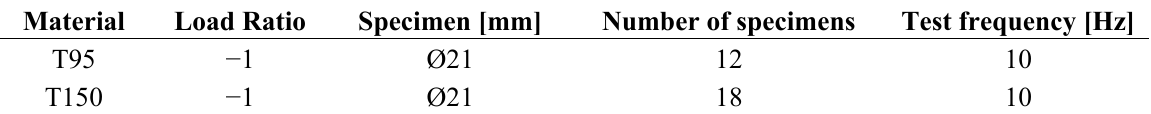
Table 2. The test plan [14].